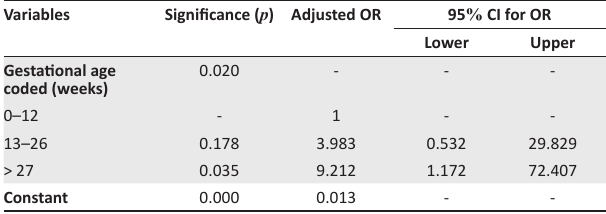
TABLE 6 : Logistic output for incidence or seroconversion of syphilis.